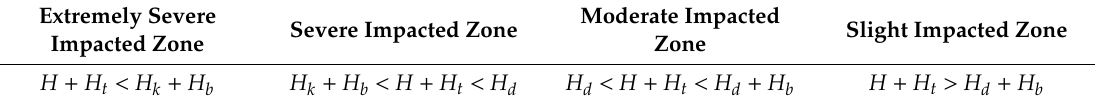
Table 6. Classification standard for coal mining’s impact level on groundwater.